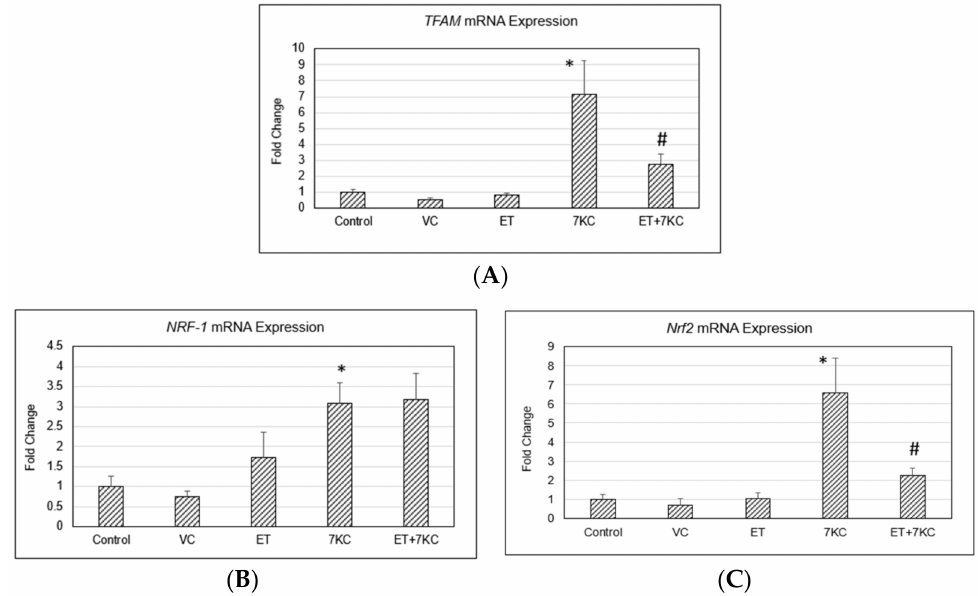
Figure 7. TFAM , NRF-1 and Nrf2 gene expression. ( A ) TFAM mRNA expression was induced by 7KC, but this increase was significantly reduced by ET. As with TFAM , there was induction of ( B ) NRF-1 and ( C ) Nrf2 , indicating increased overall level of cellular stress after treatment of cells with 7KC, and this increase was similarly significantly decreased by ET. ET did not reduce the 7KC-induced increase in NRF-1. VC: Vehicle control; ET: 1 mM ET; 7KC: 30 µ M 7KC. Data are the represented as mean ± SD (n = 4). * Significant difference compared to controls ( p < 0.05). # Significant difference compared to 7KC. Data were analysed by one-way ANOVA with Bonferroni’s multiple comparison post-hoc test.